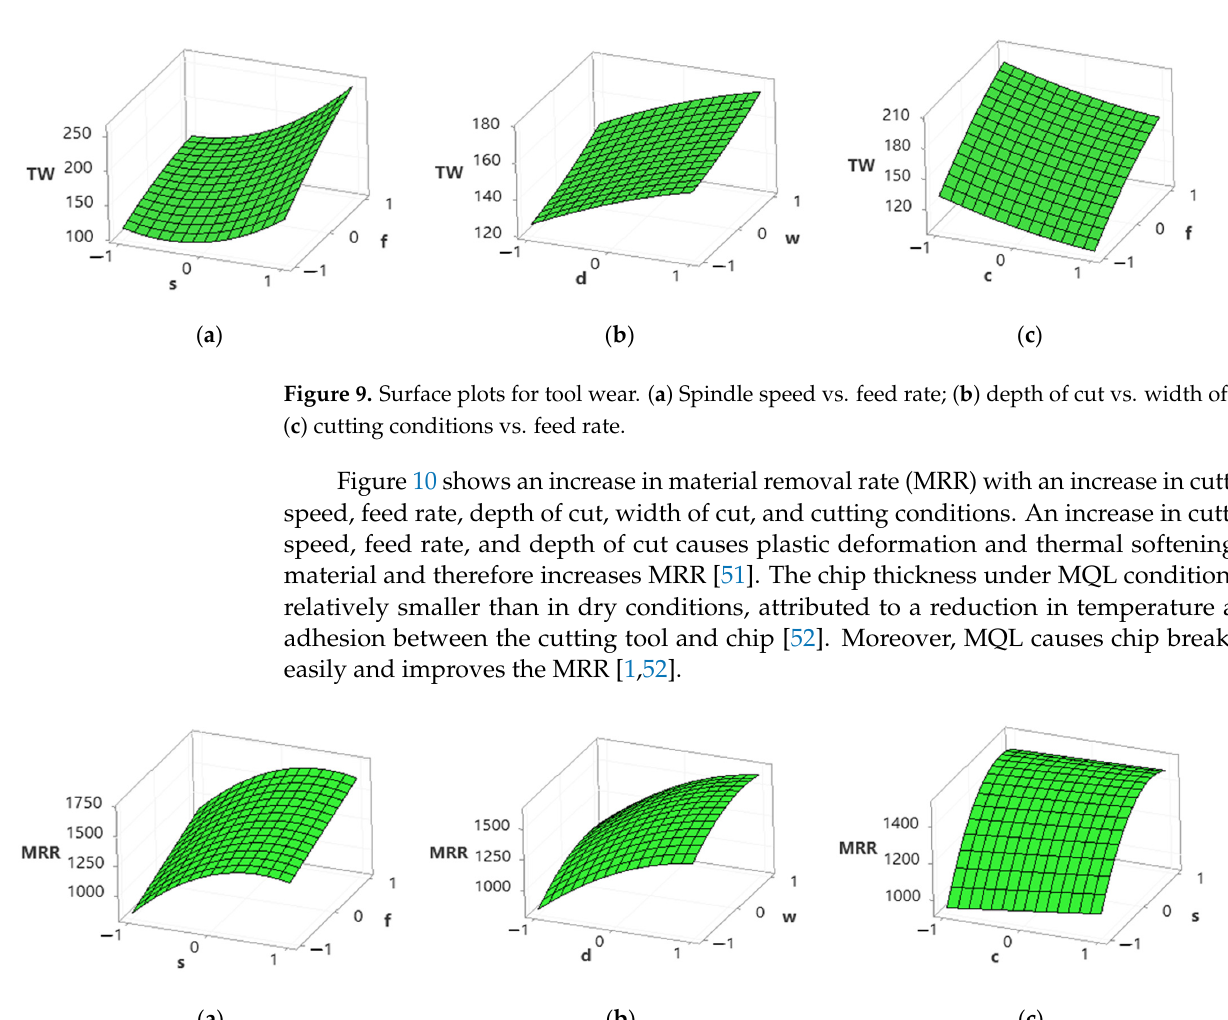
Figure 8. Surface plots for cutting forces. ( a ) Spindle speed vs. feed rate; ( b ) depth of cut vs. width of cut; ( c ) cutting conditions vs. feed rate.